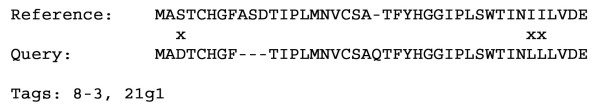
Use of tags to create an alignment. To create this alignment, the query sequence read against the reference sequence until after amino acid #8 (reference sequence numbering), then a gap of 3 residues is inserted in the query (tag 8-3; deletion of length 3 in query). The sequences are continued until amino acid #21 (reference sequence numbering), then a gap of 1 residue is the reference sequence (tag 21g1; insertion of 1 amino acid in query sequence). There is no need for substitution tags in this example because both amino acid sequences have been stored.